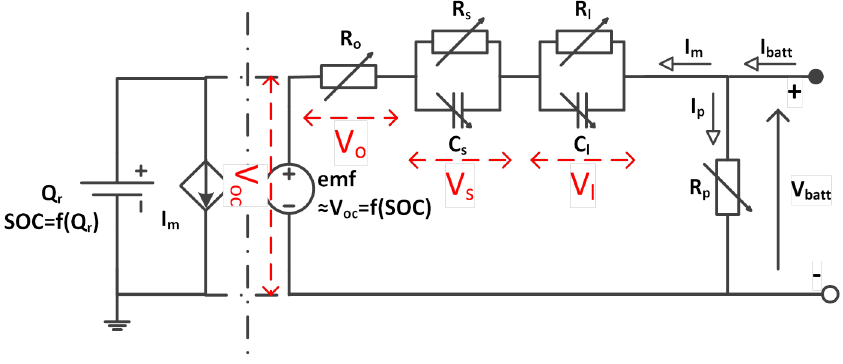
Figure 4. The construction of the EECM. The subscripts s and l stand for short and long time duration respectively with respect to voltage relaxation ( τ 1 , τ 2 in Figure